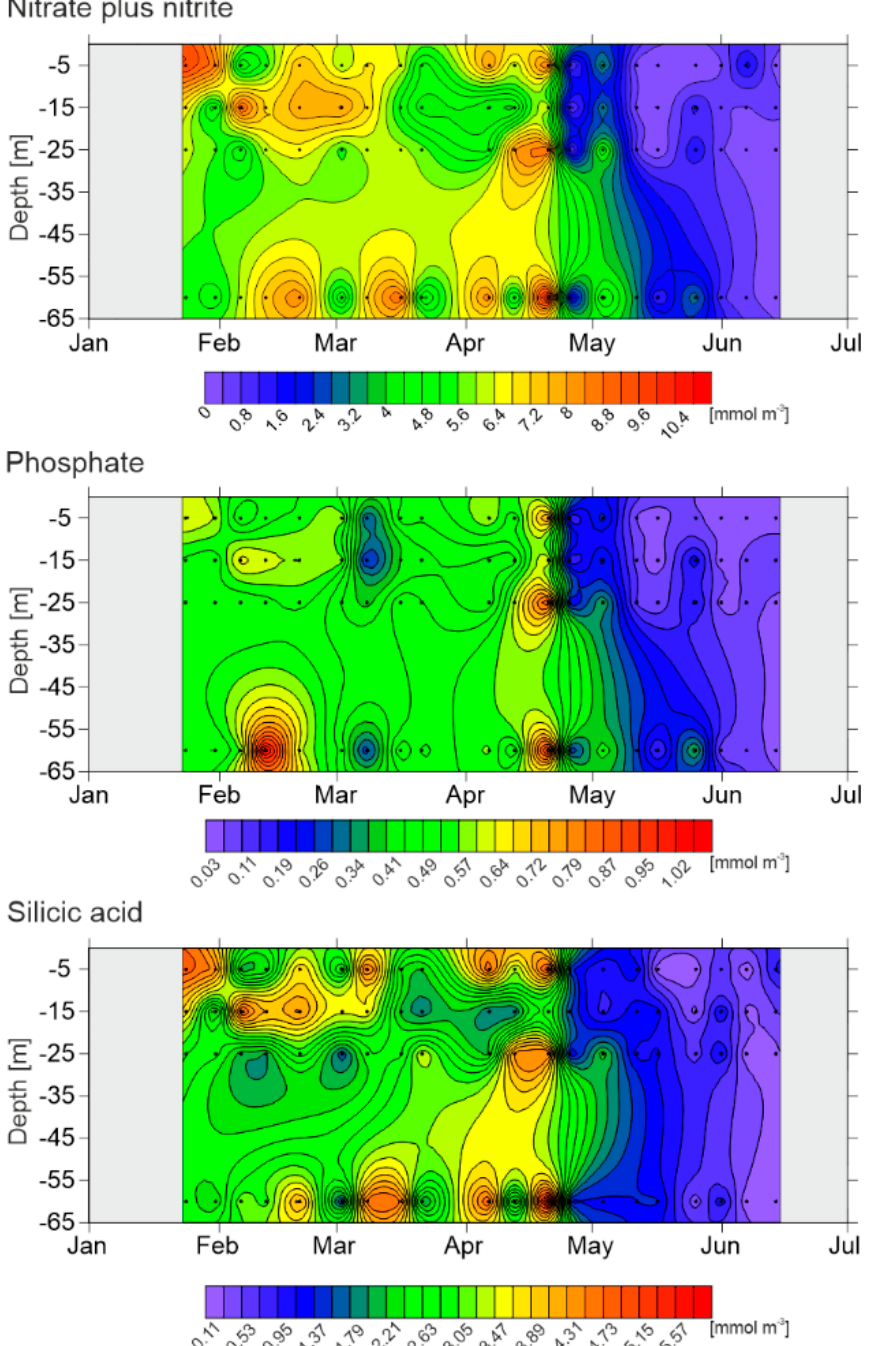
Figure 3. Nitrate plus nitrite, phosphate and silicic acid concentrations [mmol m − 3 ] during the investigated period. The areas corresponding to the missing observations are also presented (as blank).